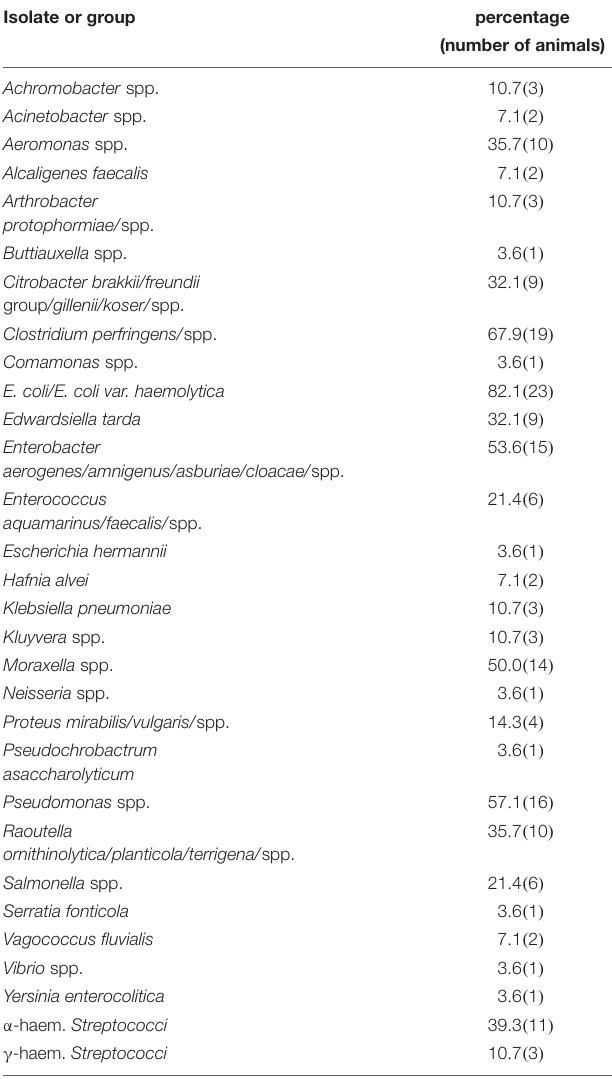
(number of animals)